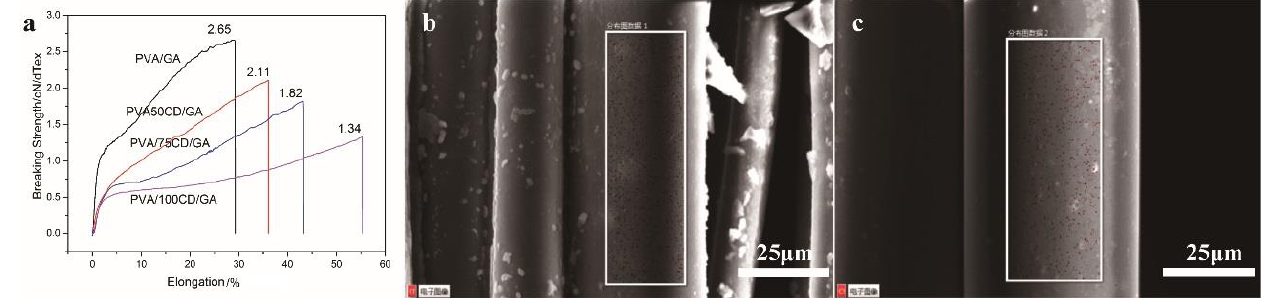
Figure 4. ( a ) Mechanical properties of PVA/GA, PVA/50CD/GA, PVA/75CD/GA and PVA/100CD/GA fibers; EDS mapping of Cl substituted PVA/75CD fiber before ( b ) and after ( c ) 10 wash cycles.